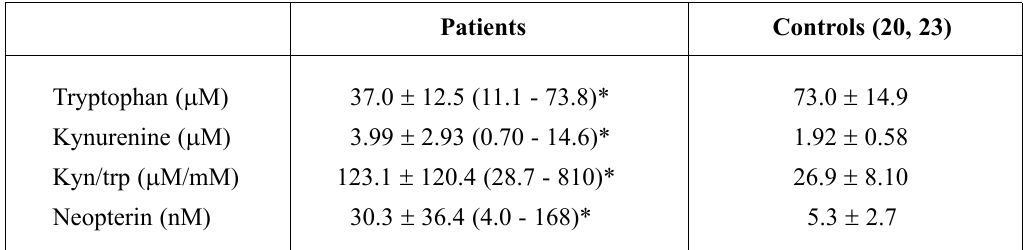
Table 2. Concentrations of tryptophan, kynurenine and neopterin and of kynurenine to tryptophan ratio (mean ± S.D., range in brackets) in patients post-trauma and/or with sepsis (18 patients, 84 measurements) and laborato- ry reference values of healthy controls; ∗ p <